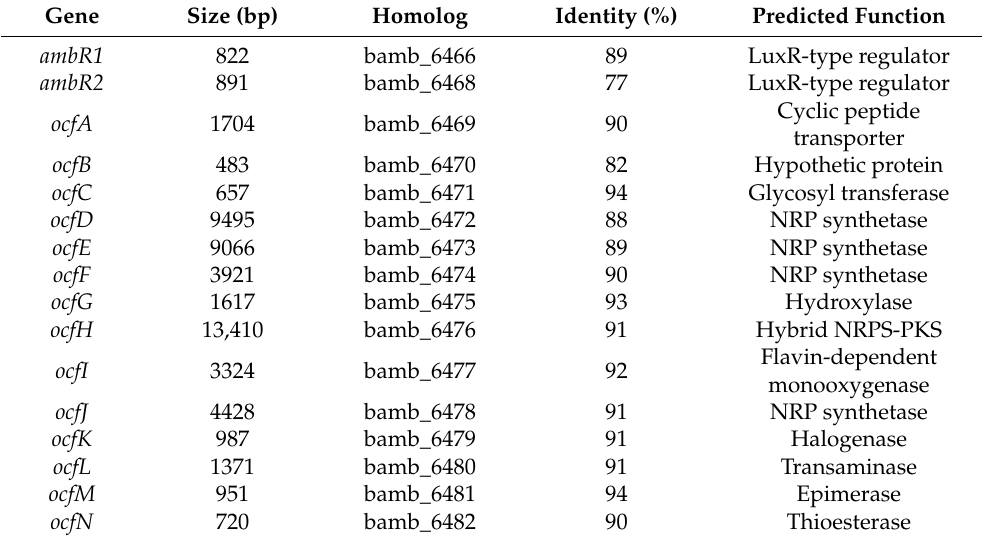
Table 1. Genes identified to be part of the ocf gene cluster. Gene homologs are compared to those found in B. ambifara AMMD. Predicted gene functions are based on B. ambifara AMMD and B. lata 383. Adapted from Gu et al